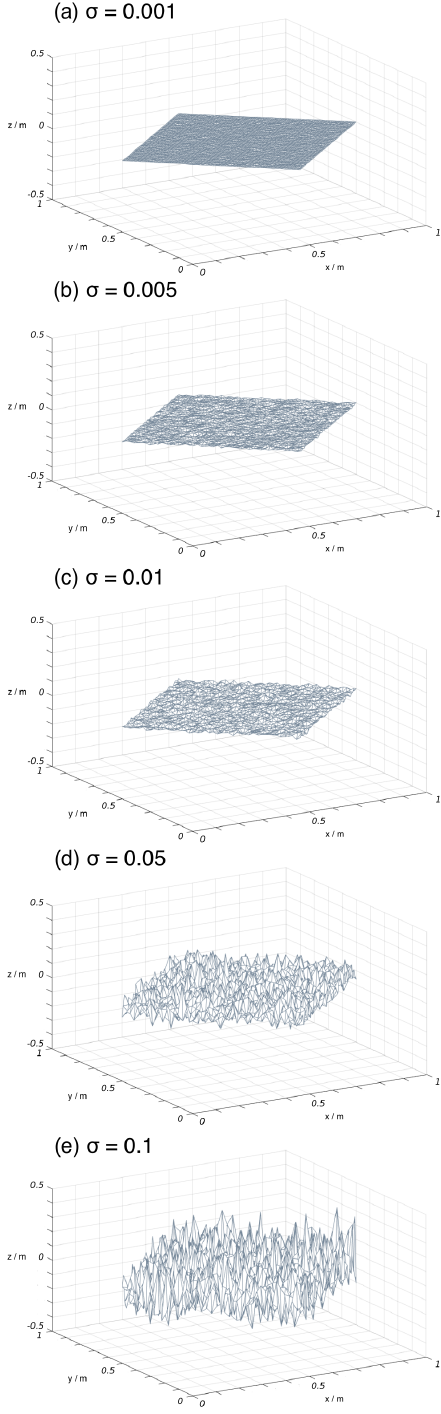
Figure 3. Visualisation of example random surface roughness input parameters, controlled by the standard deviation ( σ ) of the elevation of the surface. In this study, five surface roughnesses of (a) σ = 0 . 001, (b) σ = 0 . 005, (c) σ = 0 . 01, (d) σ = 0 . 05 and (e) σ = 0 . 1 were